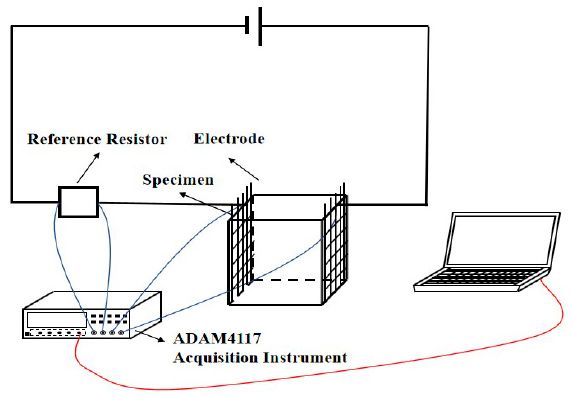
Figure 2. The schematic diagram of DC electrical resistance measurement.